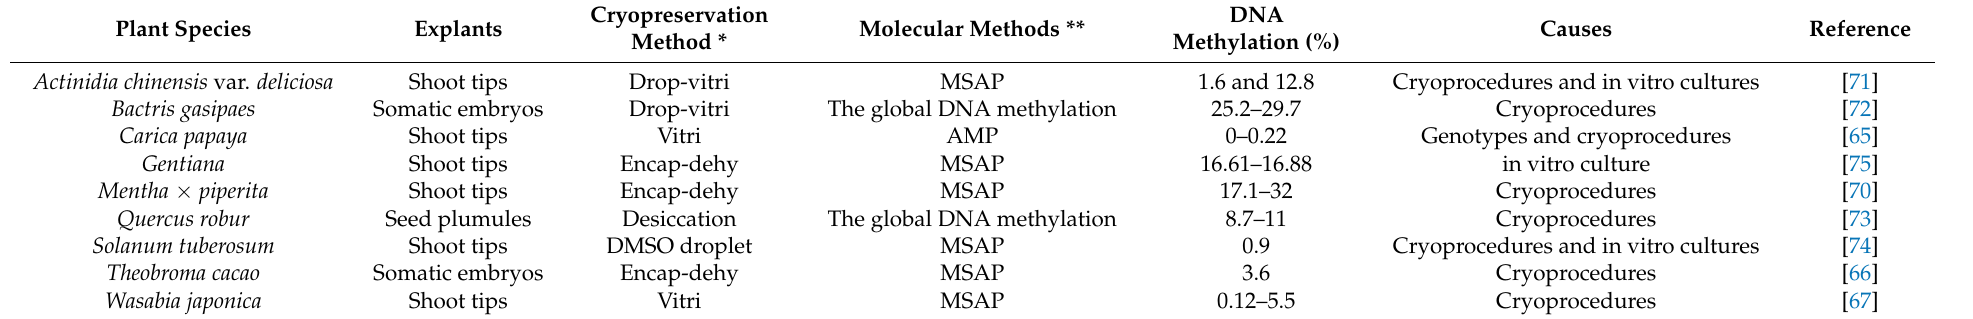
Table 1. Some examples from the past decade of epigenetic integrity assessments by DNA methylation in regenerants recovered after